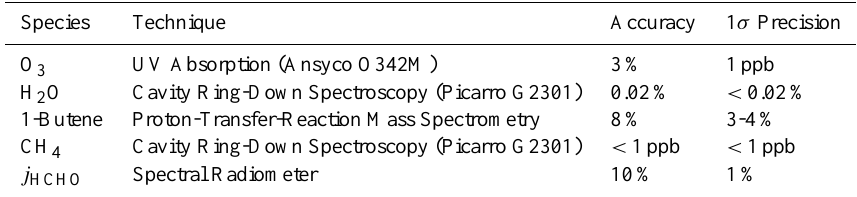
Table 1. Additional measurements accompanying the HCHO intercomparison. Species Technique Accuracy 1 σ Precision O 3 UV Absorption (Ansyco O342M) 3% 1ppb H 2 O Cavity Ring-Down Spectroscopy (Picarro G2301) 0.02% < 0.02% 1-Butene Proton-Transfer-Reaction Mass Spectrometry 8% 3-4% CH 4 Cavity Ring-Down Spectroscopy (Picarro G2301) < 1ppb < 1ppb j HCHO Spectral Radiometer 10%